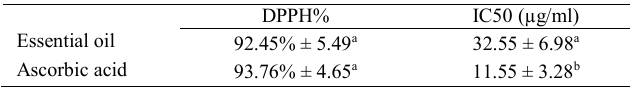
Table 2. Antioxidant property of nano emulsion of clove essential oil